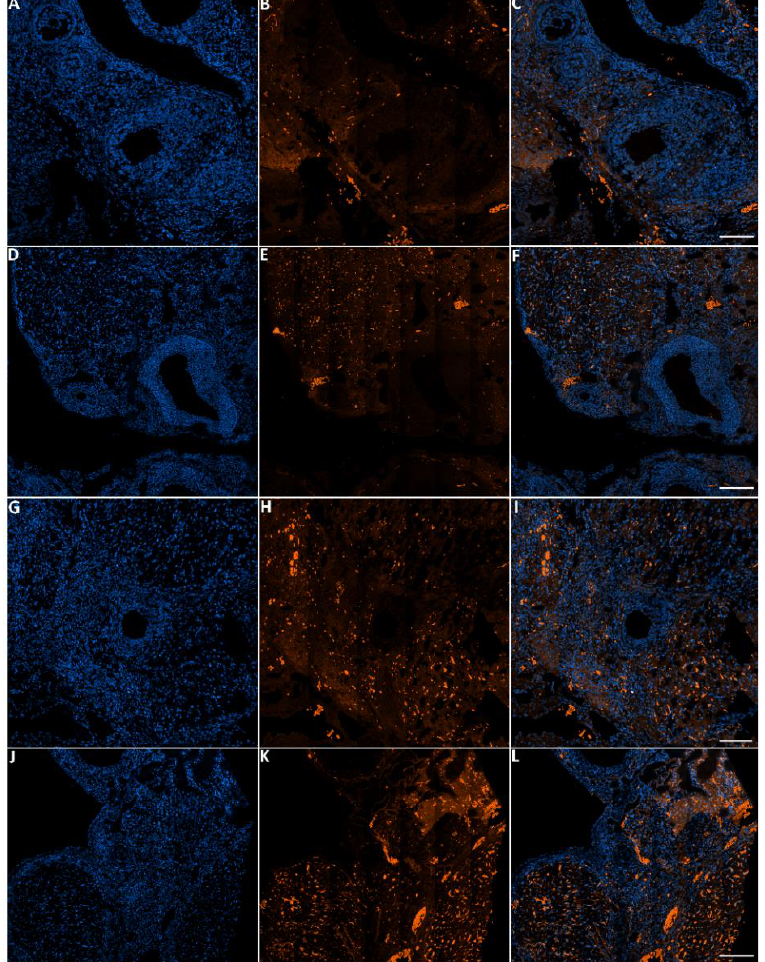
Figure 9. Representative images of apoptosis in ovaries from the control and treated groups stained with Hoechst and TMR red. Ovaries from control ( A – C ), ovaries from females that were exposed to 2000 ppm ( D – F ), 4000 ppm ( G – I ) and 8000 ppm ( J – L ). Scale bars = 100µm.